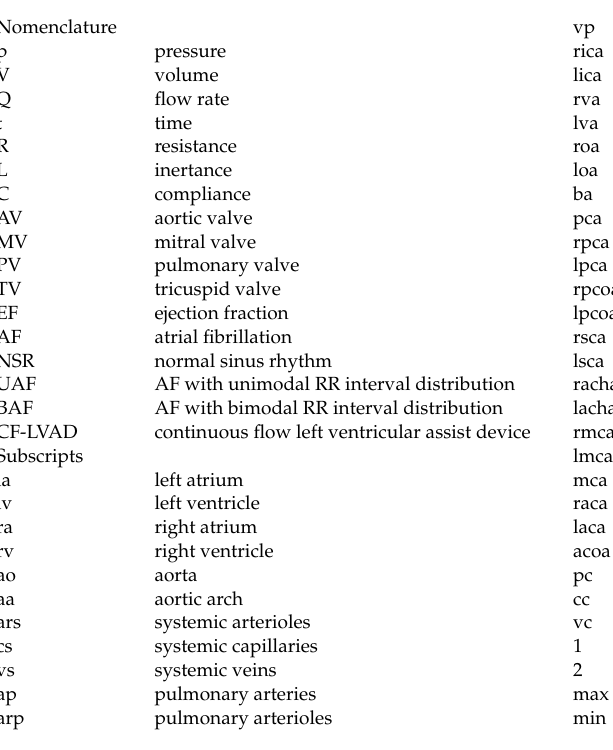
Table A1. List of